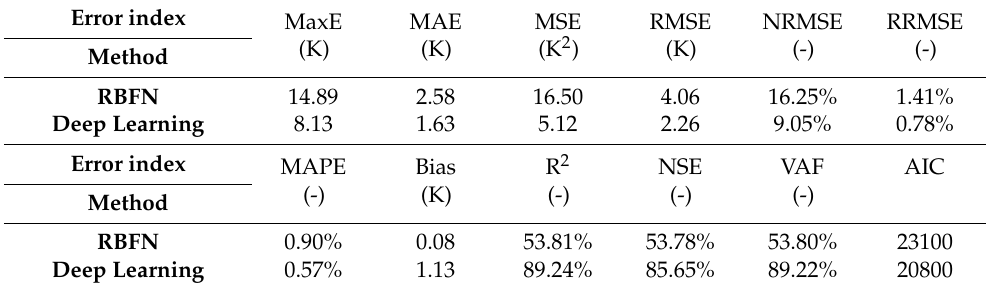
Table 2. Error analysis of interpolated soil temperature values using different AI